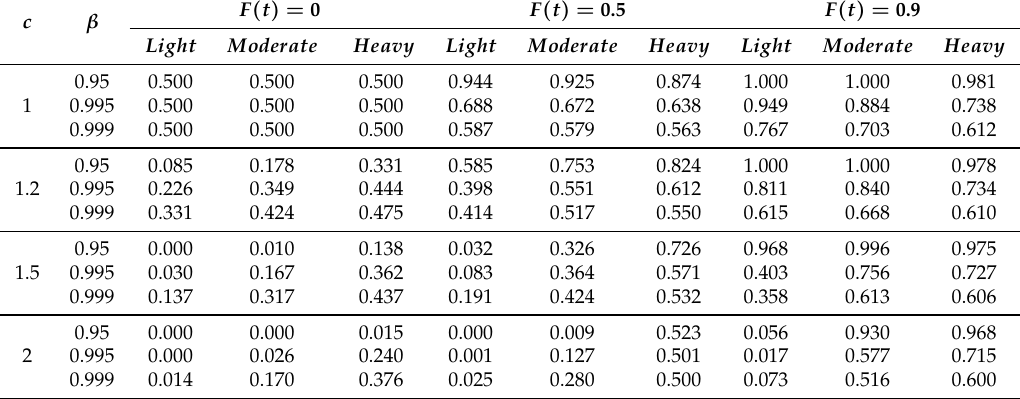
Table 1. Function H ( c ) evaluated for various combinations of c , confidence level β , proportion of unobserved data F ( t ) , and severity distributions with varying degrees of tail heaviness ranging from light- and moderate-tailed to heavy-tailed. The sample size is n =